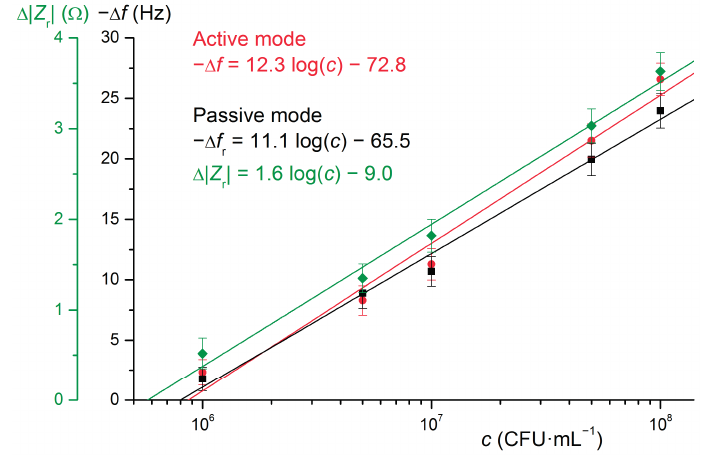
Figure 5. Calibration curves for determination of E. coli DH5 α using active and passive QCM immunosensors based on antibody Abcam ab25823 immobilized directly using